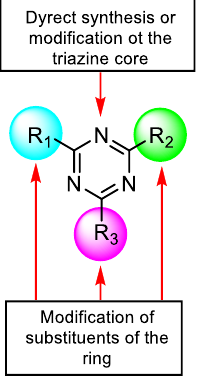
Figure 1. Synthetic approaches to obtain substituted triazines.